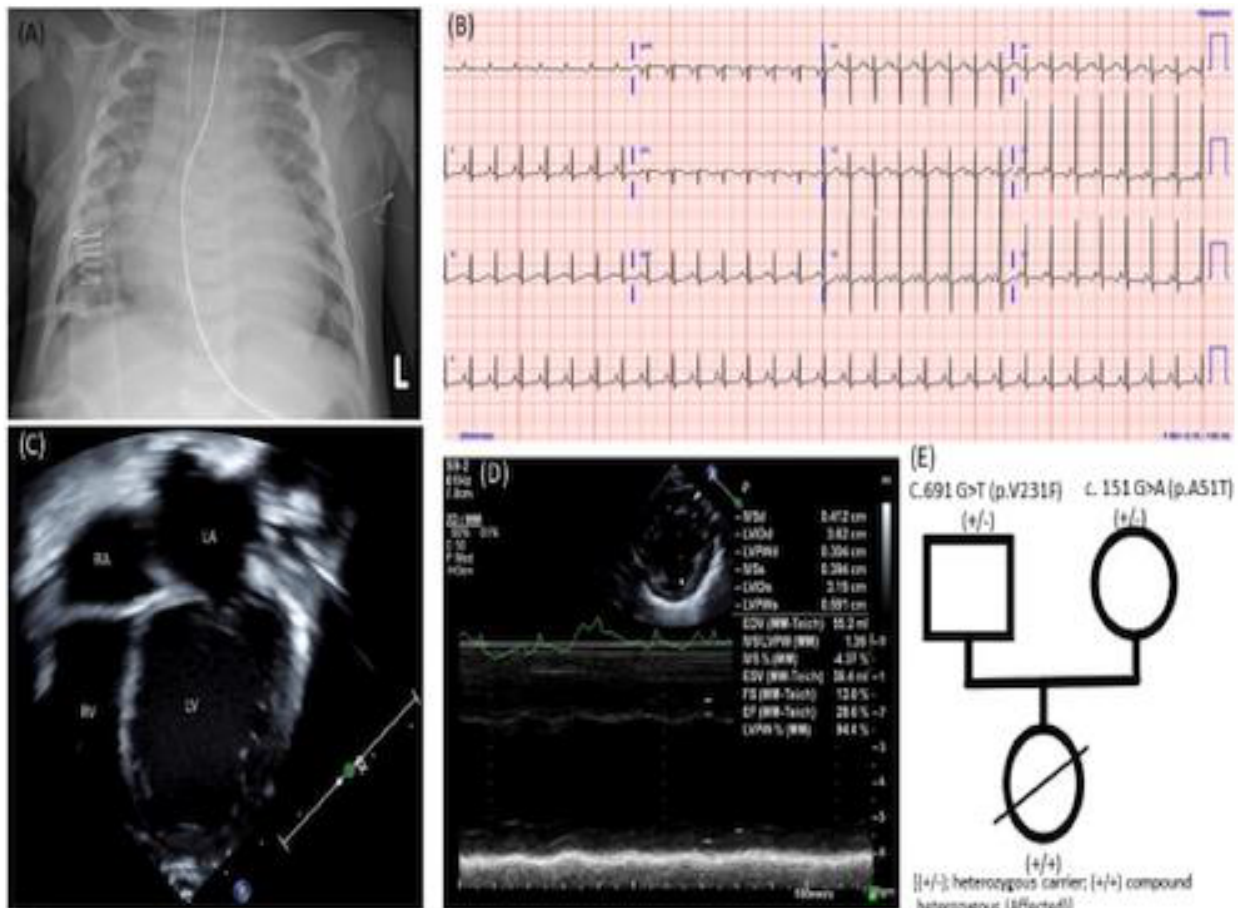
Figure 1. ( A ) Chest X-ray showing severe cardiomegaly at presentation; ( B ) electrocardiogram showing nonspecific ST changes (flat); ( C ) four-chamber view showing a dilated left atrium (LA) and left ventricle (LV); ( D ) m-mode echocardiography displaying depressed LV systolic function (LVSF 13%); ( E ) family pedigree tree.